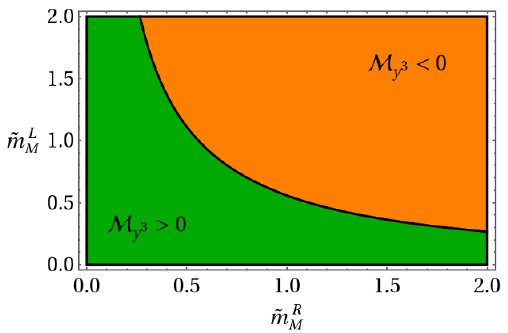
Figure 1 . Sign of M as a function of the Majorana masses. The green (darker) region correspond y 3 to M > 0, while the orange (brighter) region indicates M y 3